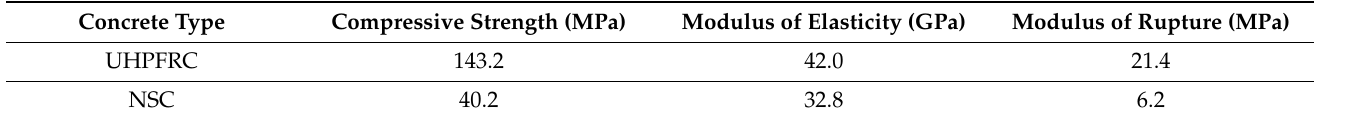
Table 2. Measured mechanical properties of UHPFRC and